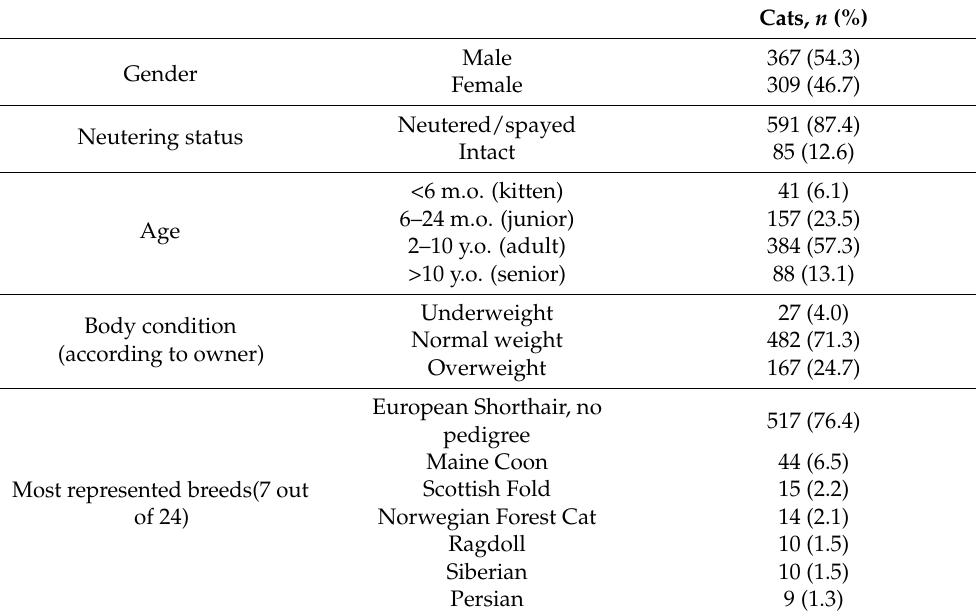
Table 3. Characteristics of cats enrolled in the study ( n =